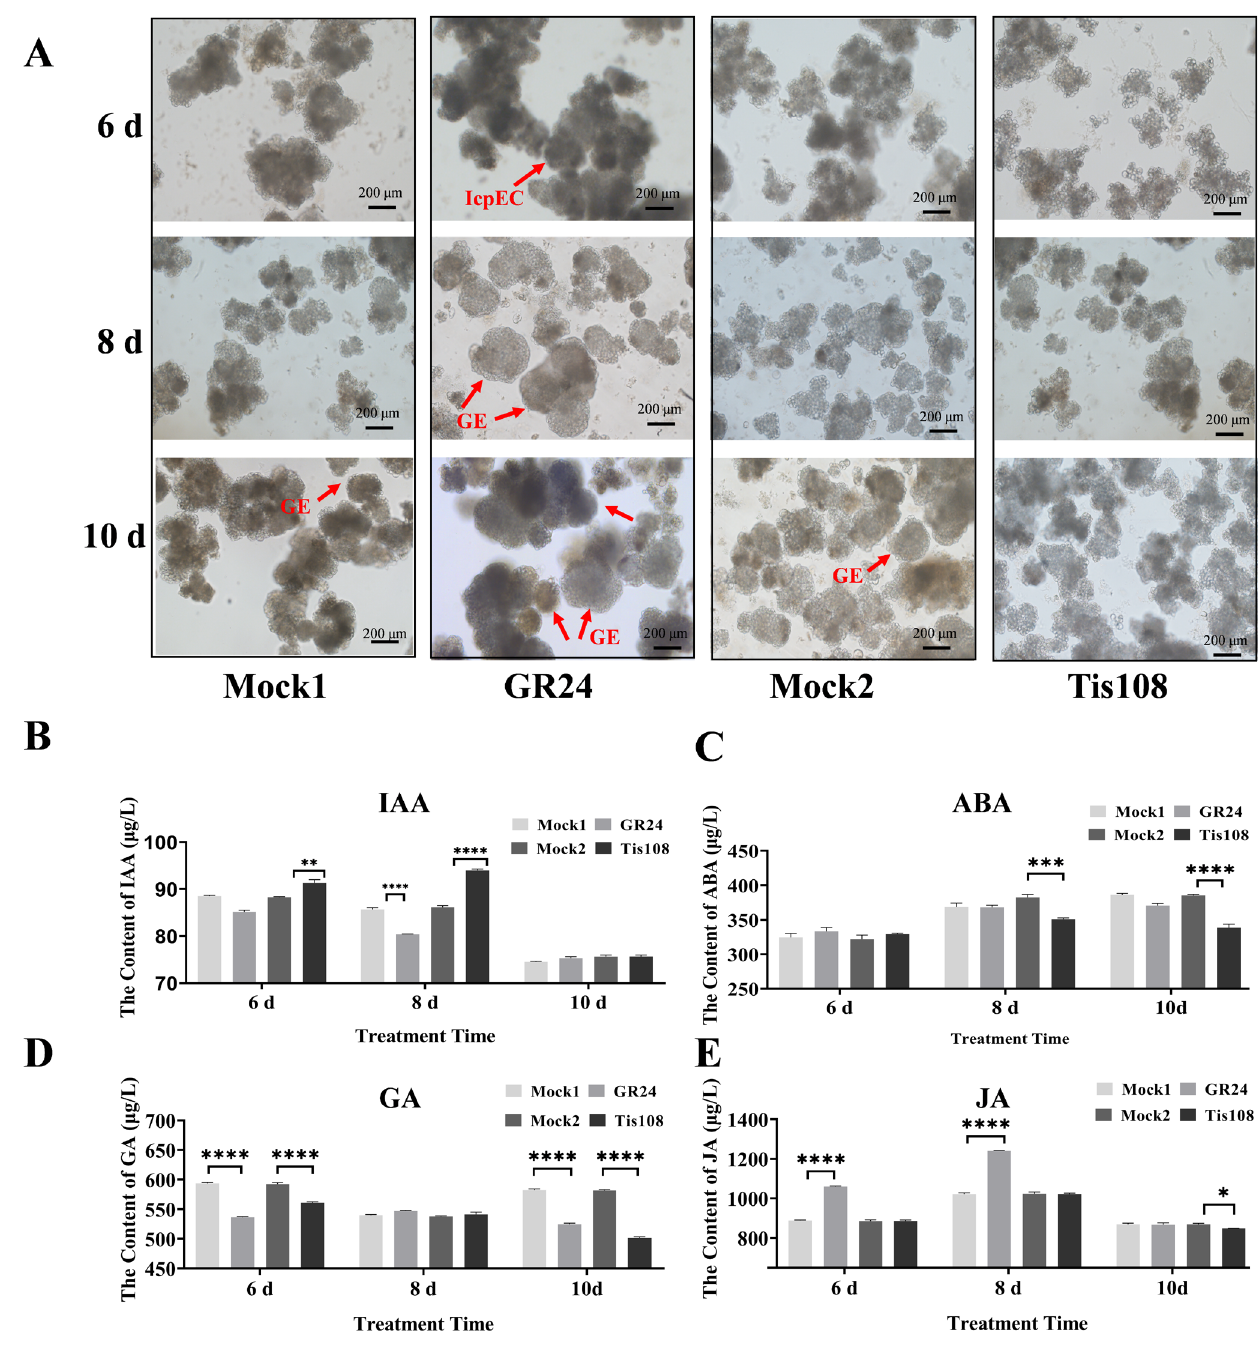
Figure 7. ( A ) Morphological change in embryogenic callus under GR24 and Tis108 treatment. The appearance globular embryo is marked by red arrows. ( B – E ) Changes in the endogenous IAA, ABA, GA, and JA content of longan somatic embryos upon GR24 and Tis108 treatment. Significant differences are indicated with “*” ( p < 0.05), “**” ( p < 0.01), “***” ( p < 0.005), or “****” ( p < 0.001).